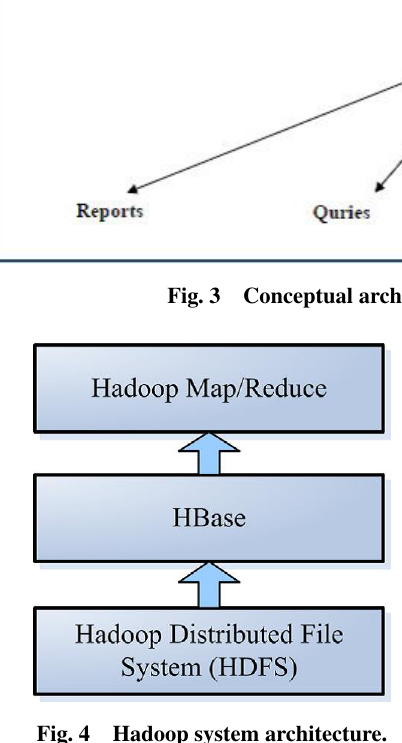
Fig. 4 Hadoop system